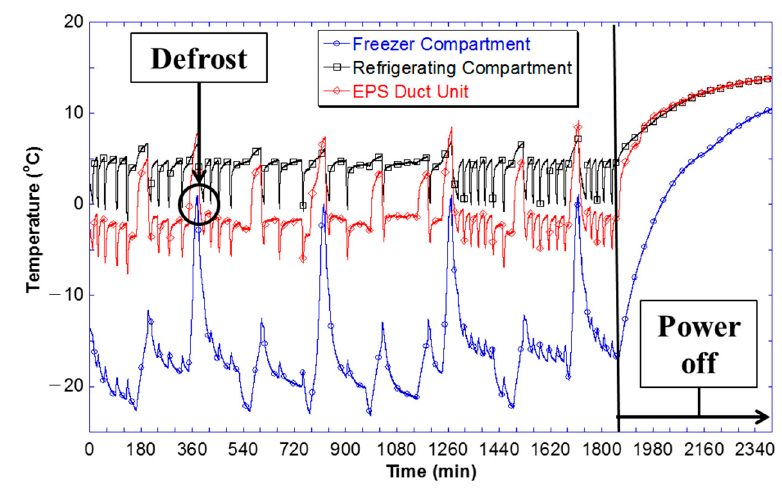
Figure 7. Measured temperatures inside the refrigerator as a function of time.